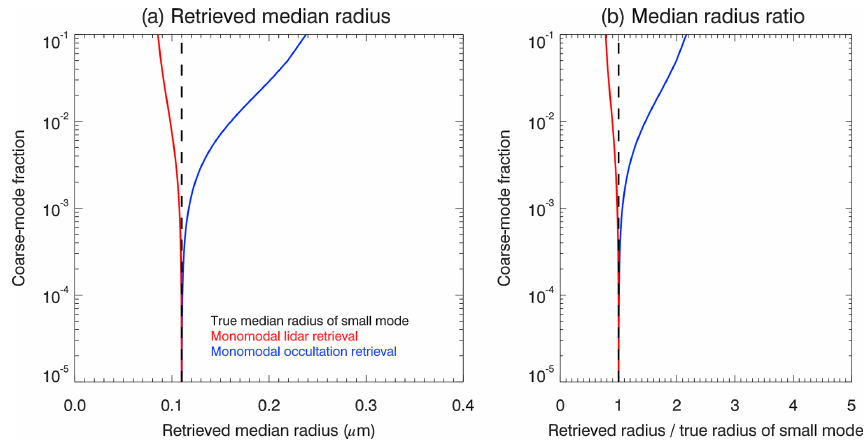
Figure 11. Similar to Fig. 3 but for a different set of parameters of the bimodal particle size distribution ( r 1 = 110nm, S 1 = 1 . 4, r 2 = 350nm, S 2 = 1 . 2; i.e., case 3 in Table